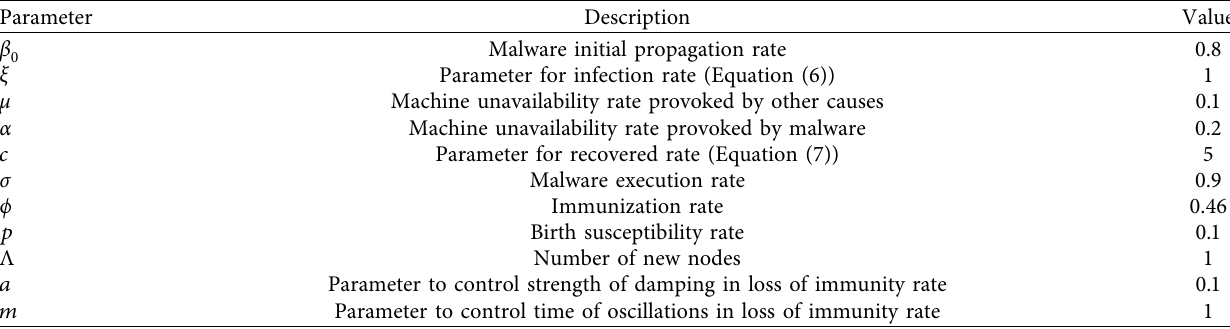
Table 3: Initial parameters of the model for the experiments.